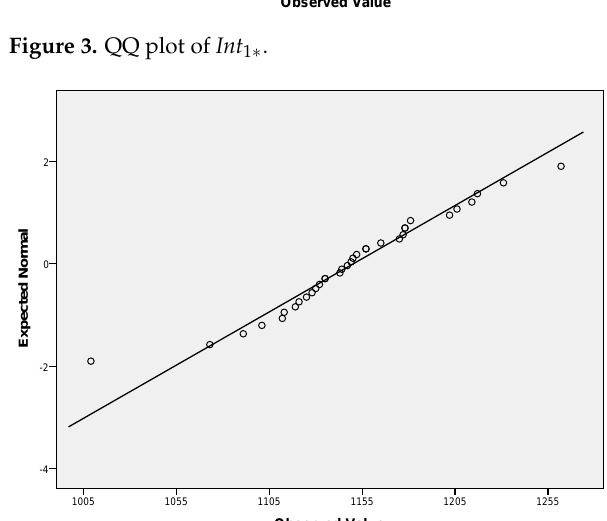
Figure 4. QQ plot of Int 2 ∗